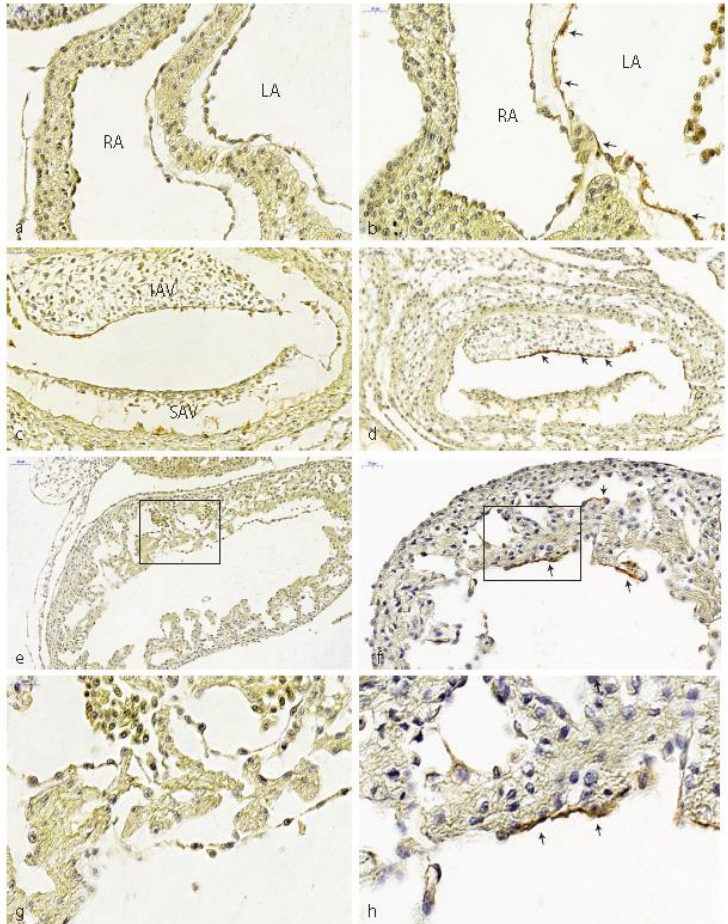
Figure 2. Expression of TGF β type III receptor. ( a ) Normal left and right atrium of HH20. No TBRIII expression in atrial endocardium. ( b ) Ligated embryo with ectopic TBRIII expression along the atrial septum and atrial floor (arrows). ( c ) AV cushions of normal HH22 embryo, TBRIII expression is downregulated. ( d ) Ligated embryo with prolonged endocardial TBRIII expression (arrows). ( e ) Normal HH20 embryo, ventricular trabeculations lack TBRIII. ( f ) Ectopic TBRIII expression of the endocardium lining ventricular trabeculations after ligation (arrows). ( g ) Higher magnification of the boxed area of ( e ). ( h ) Higher magnification of the boxed area of ( f ). IAV: inferior AV cushion, LA: left atrium, RA: right atrium, SA: superior AV cushion.